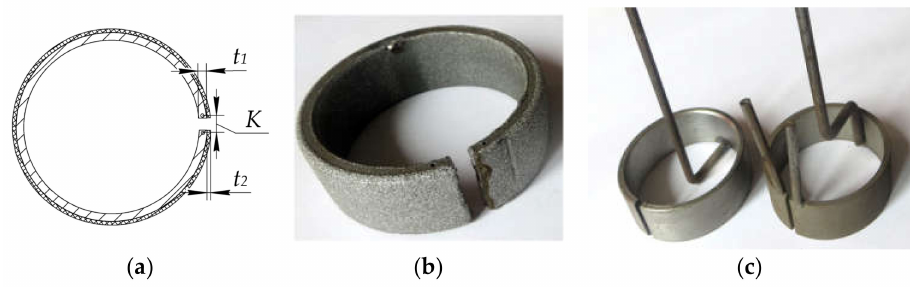
Figure 2. Scheme ( a ) and specimens ( b , c ) for determining residual stresses in